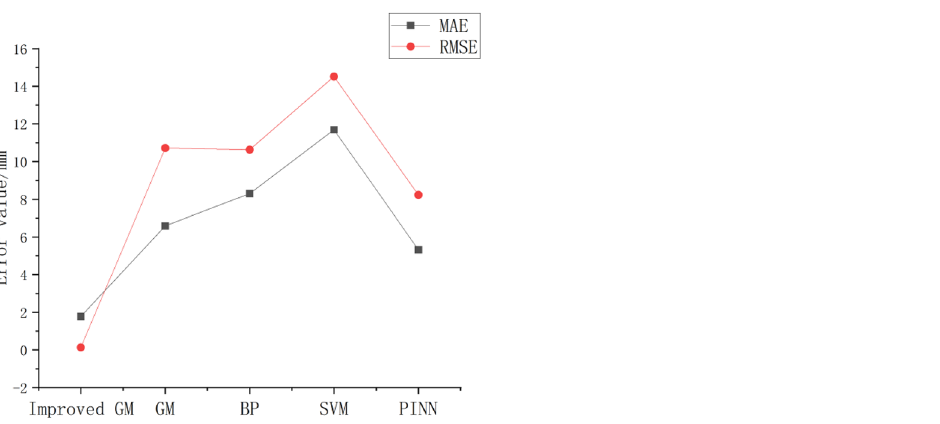
Figure 9. Comparison of algorithm MAE and RMSE.